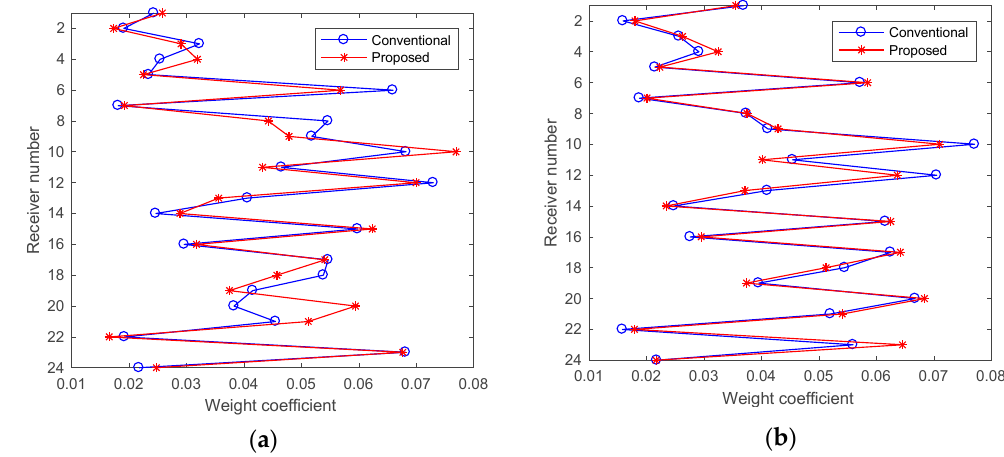
Figure 6. The TR-MRC weight coefficients calculated using different methods. ( a ) 50 km UWA communication; ( b ) 80 km UWA communication.